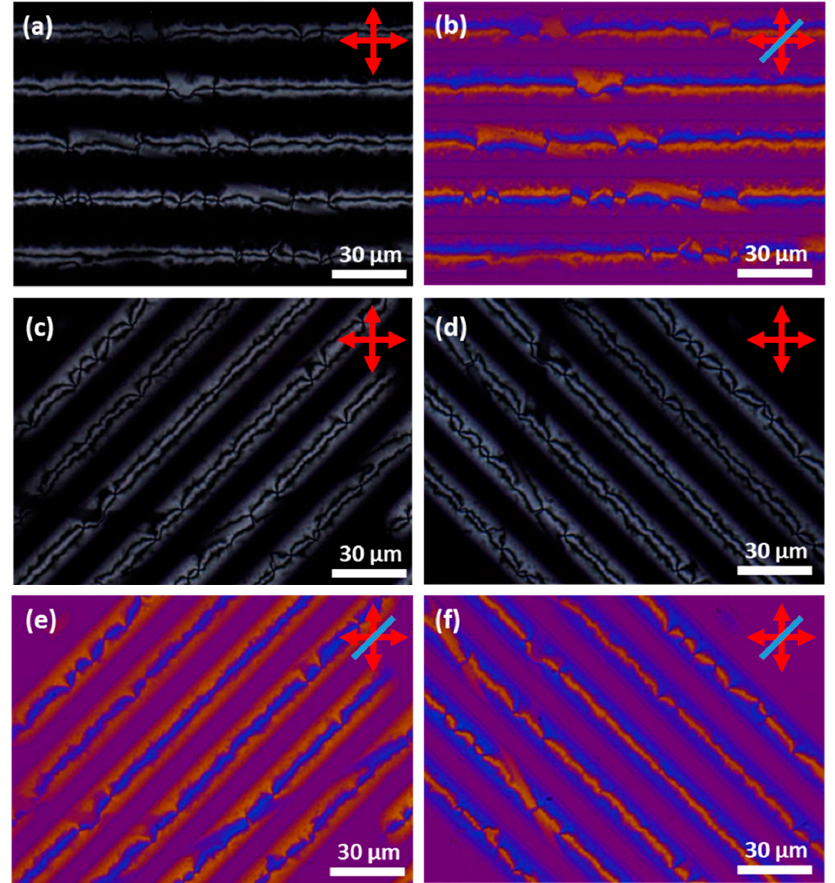
Figure 11. POM images for de ‐ wetted stripes of MLC7023. Hydrophilic stripes 25 μ m wide and hydrophobic stripes 10 μ m wide. ( a ) Crossed polarisers with the stripes parallel to one polarisation direction. ( b ) With an added wave plate. ( c , d ) Crossed polarisers with the stripes at +45° and − 45° to the vertical. ( e , f ) With an added wave plate. The blue line indicates the orientation of the slow axis of the compensator.